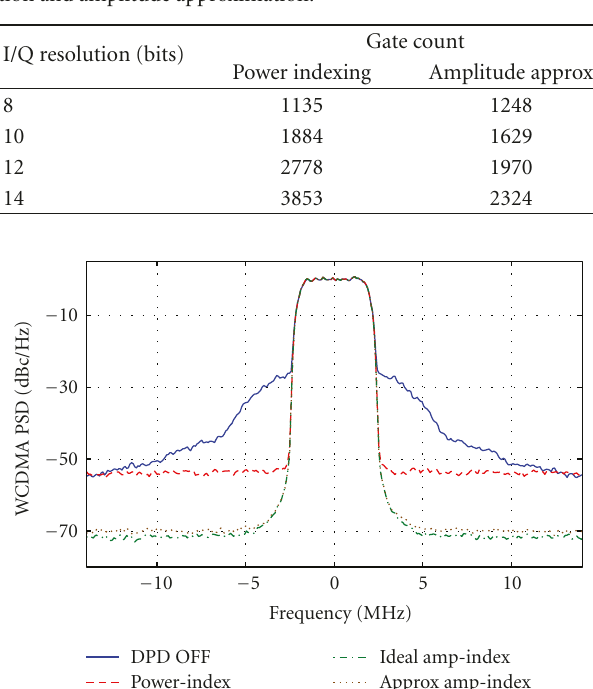
Table 3: Nand2-equivalent gate count for power index computa- tion and amplitude approximation.